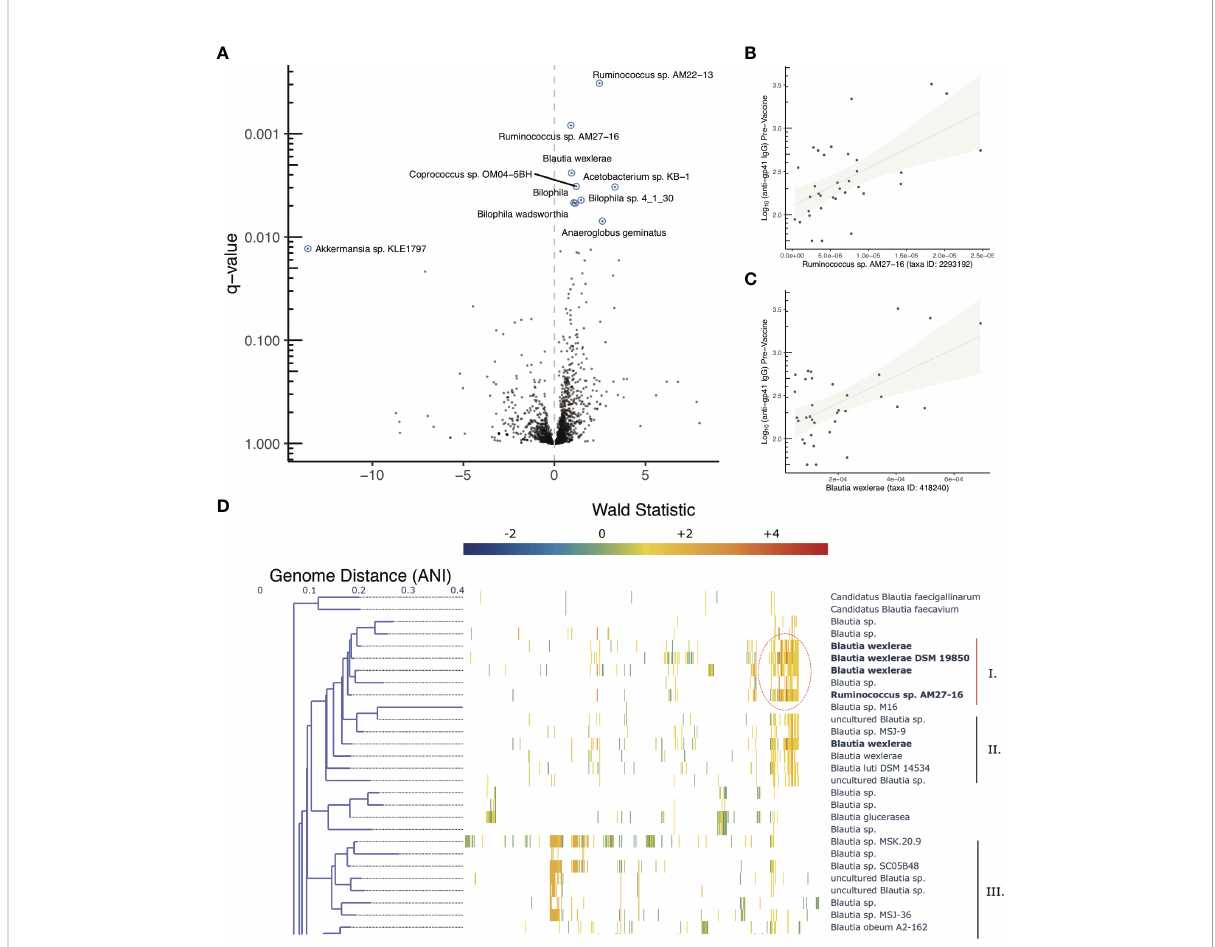
FIGURE 5 Microbiome associations with pre-vaccine gp41 IgG and Clustered co-abundant genes (CAGs) from fecal samples collected in HVTN 106. (A) Volcano plot of taxonomic features (the sum of all genes identi fi ed as part of any Clustered co-abundant genes (CAGs) assigned to a taxa, (B, C) Relative abundance of two of the most statistically signi fi cant taxa (x-axis) compared with pre-vaccine anti-gp41IgG (y-axis). (D) Fine scale mapping of genes identi fi ed in CAGs to genomes in the Blautia genus. Gene ’ s are mapped to genomes if they share 90% alignment identity at the amino acid level. The genes belonging to CAGs most consistently associated with anti-gp41 IgG pre vaccine have higher positive Wald statistics. Figure S3 shows the full tree, containing members of the genus lacking genes associated with anti-gp41